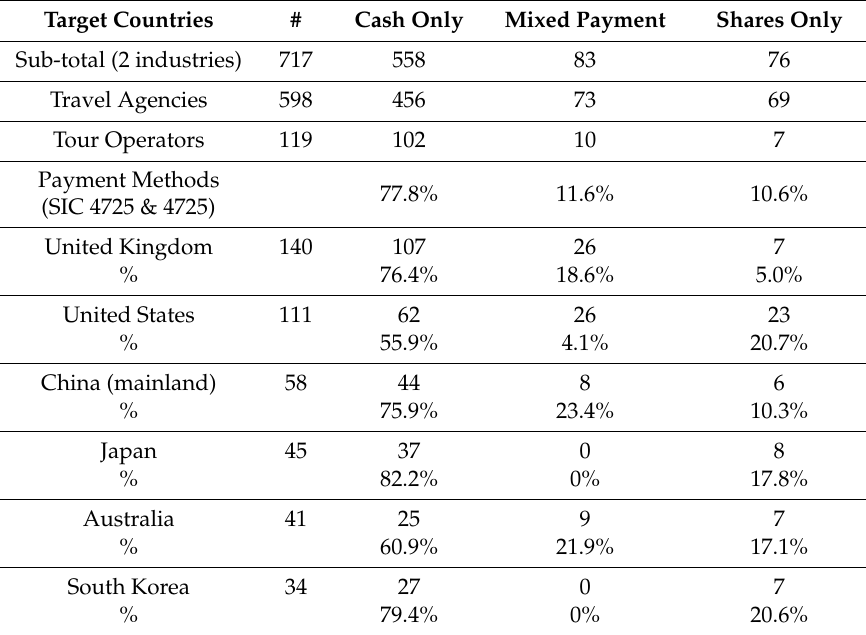
Table 1. Summary statistics of the sample and of the top six target